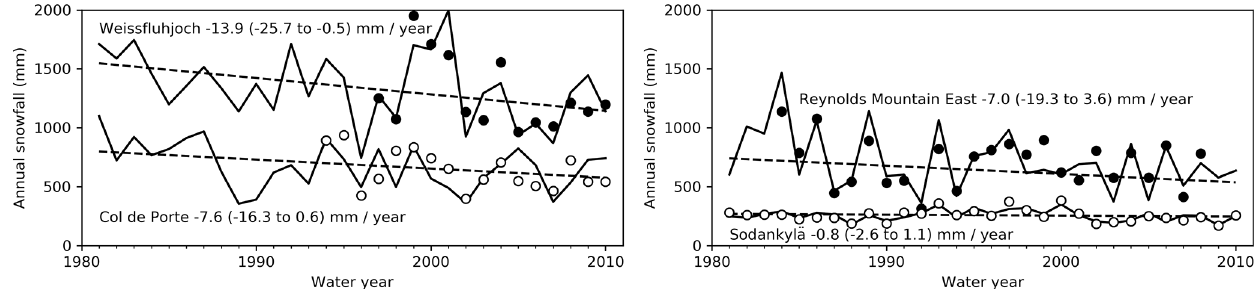
Figure 3. Water equivalent snowfall calculated from measurements at the sites (open and filled circles) and the driving data (solid lines) for water years starting on 1 October. Driving data trends are given with 95% confidence intervals in